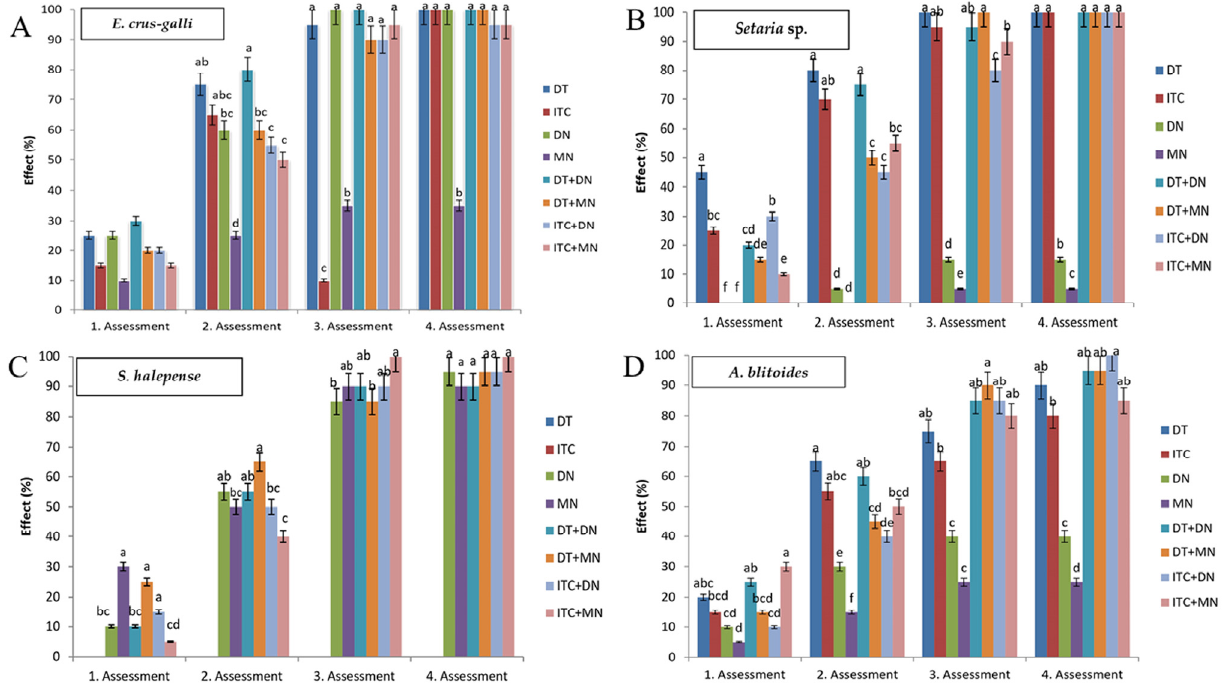
Figure 3. Effect of herbicides on ( A ) E. crus-galli , ( B ) Setaria sp., ( C ) S. halepense , and ( D ) A. blitoides at different intervals. The differences between the means with the same letter are not significant at the 0.05 level.